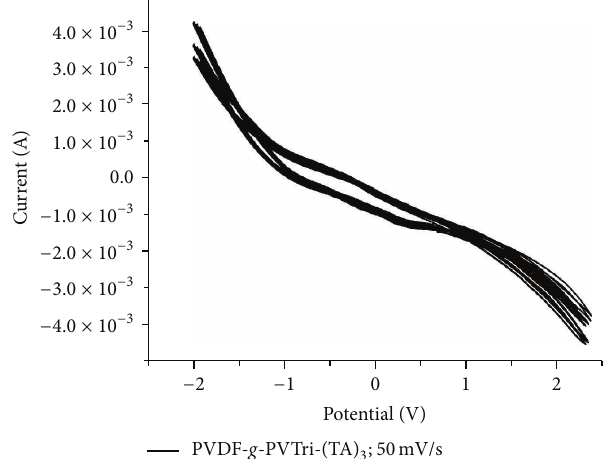
Figure 9: Cyclic voltammograms of PVDF- g -PVTri-(TA) 3 in 0.1M TBATFB/acetonitrile. Curves were obtained with a scan rate of 50